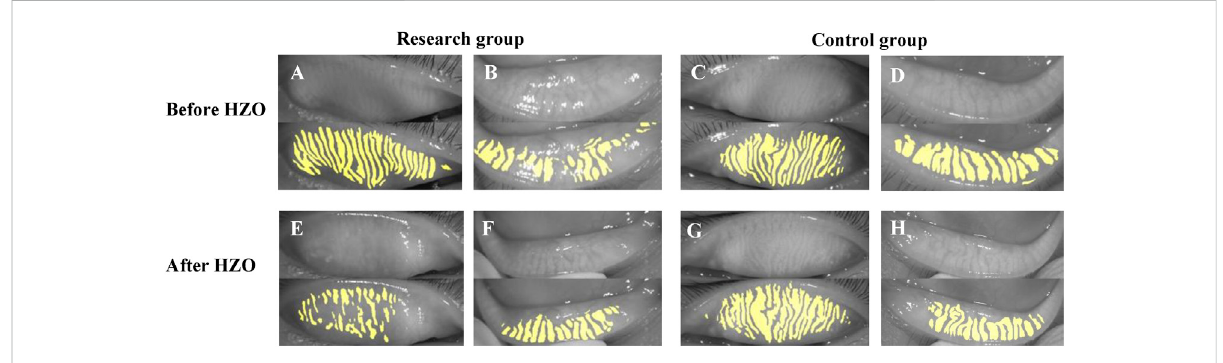
FIGURE 7 ThephotographofMGbeforeandafterHZO. (A – D) showedthephotographofMGbeforeHZO,and (E – H) showedthephotographofMGafter HZO. (A,B,E,F) were the research eyes with HZ infection, and (C,D,G,H) were the control eyes without HZ